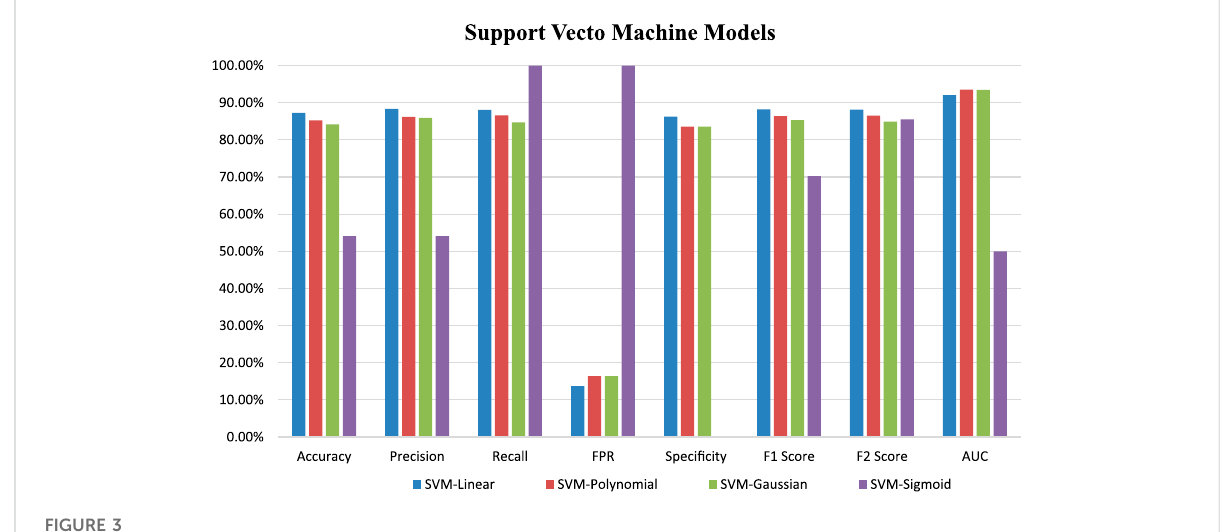
FIGURE 3 Graphical representation of developed SVM models performance based on evaluation parameters.